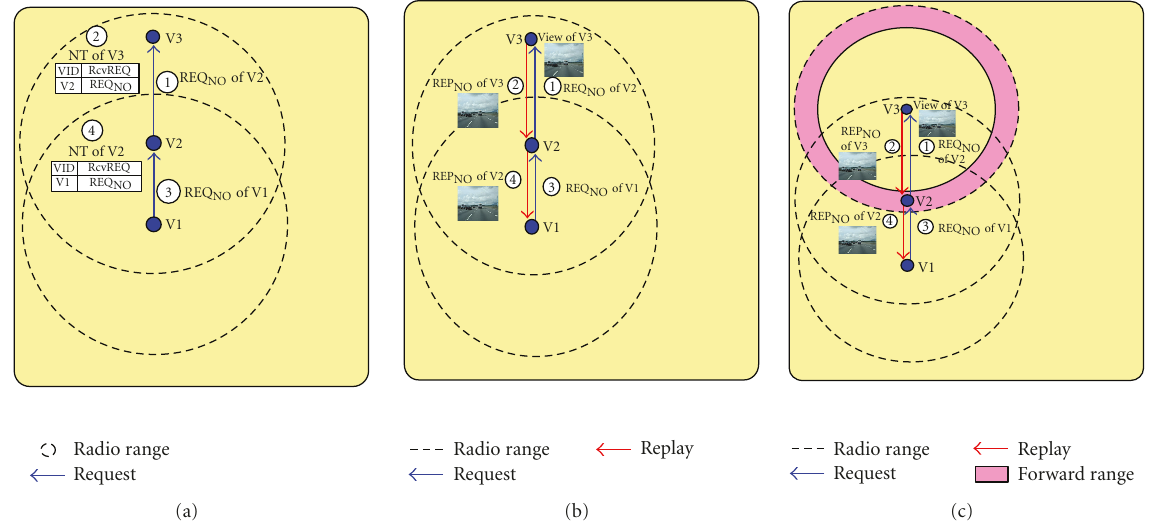
Figure 3: The handling of a received request (a) forward (b) reply of REP NO (c) reply of REP NB